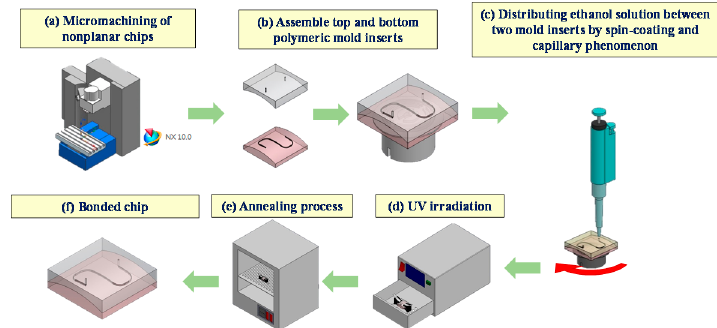
Figure 1. Layout of nonplanar microfluidic chip with S ‐ microchannel: ( a ) design and dimensions of top cover (top view); ( b ) design and dimensions of top cover (side view); ( c ) design and dimensions of bottom substrate (top view); ( d ) design and dimensions of bottom substrate (side view).